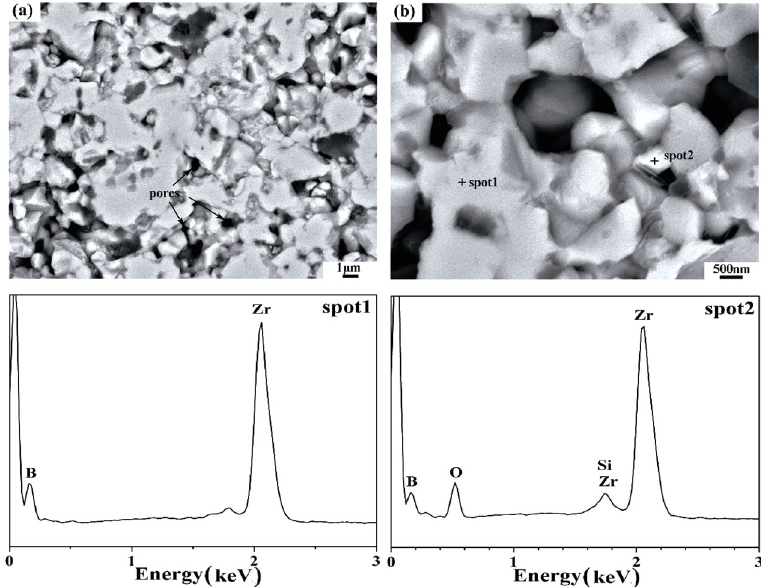
Fig. 2 Back-scattered electron (BSE) images acquired on the polished section of ZrB 2 –SiBCN ceramics with 5 wt% ZrO 2 sintered at 1600 ℃ for 15 min and EDS patterns of two